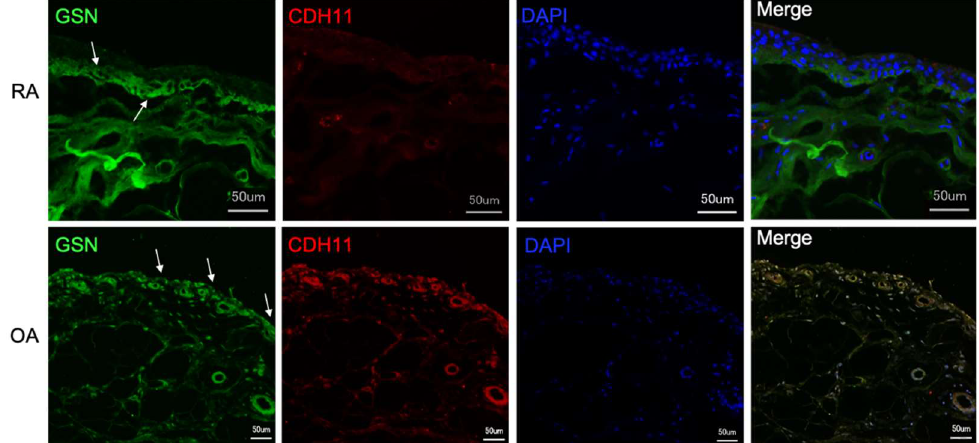
Figure 5. Gelsolin detection in synovial membranes and fluids of RA and OA patients. Immunofluorescence detection of gelsolin (GSN—green, white arrows) in the synovial membrane of patients with rheumatoid arthritis (RA) and osteoarthritis (OA). Paraffin-embedded tissue sections are stained with antibodies against CD68 (red) and CDH11 (red) to localize macrophage-like synoviocytes (MLS) and fibroblast-like synoviocytes (FLS) as well as gelsolin (GSN) to localize GSN. GSN is detectable in the subepithelial tissue of the RA synovial membrane (top row) and in the superficial cell layers of the synovial membrane of OA patients (bottom row).